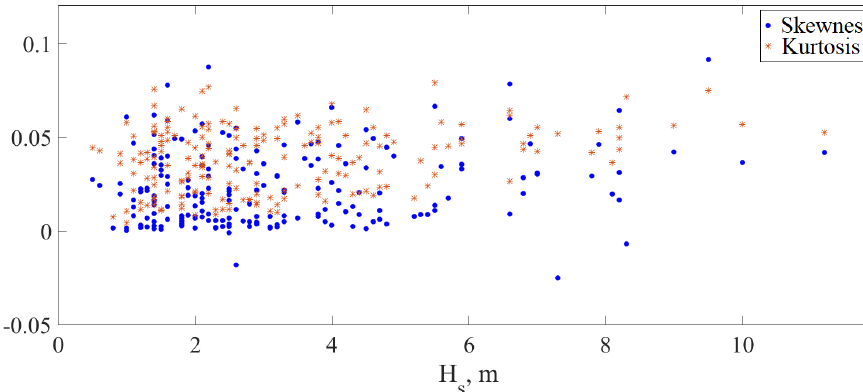
Figure 12. Distributions of skewness and excess kurtosis versus significant wave height.